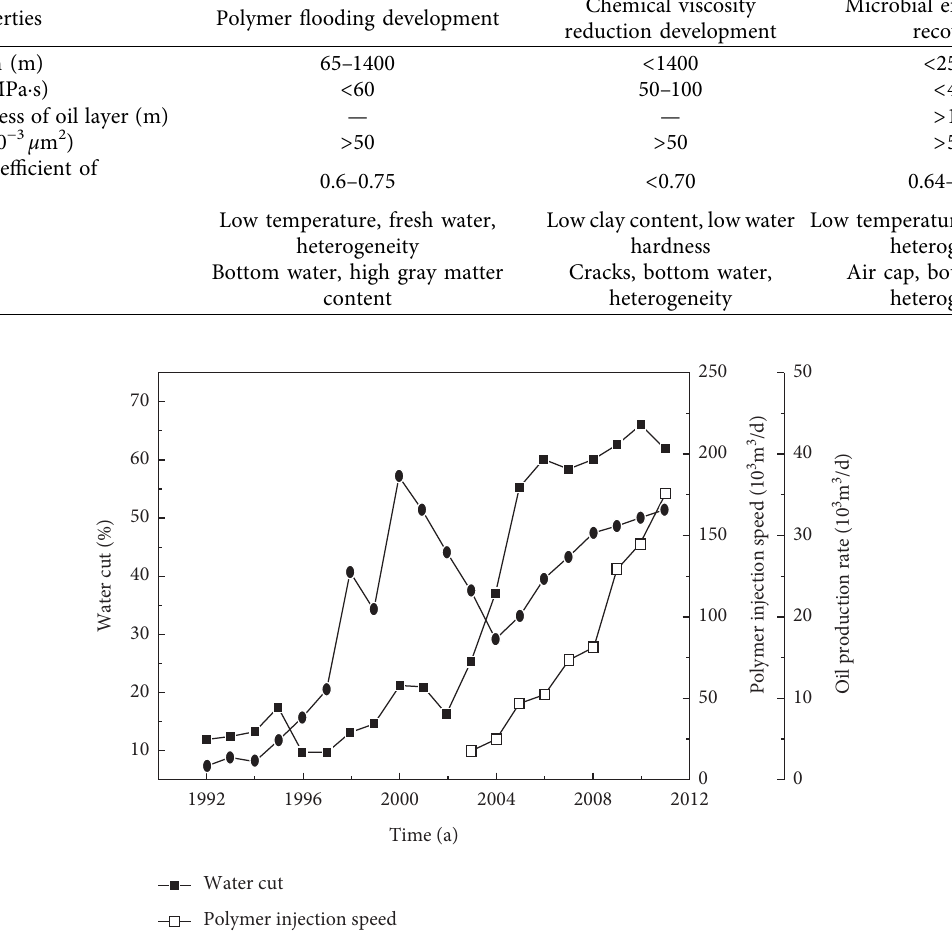
Figure 10: Changes in the crude oil production, polymer injection rate, and water cut in block HTLP 6 over